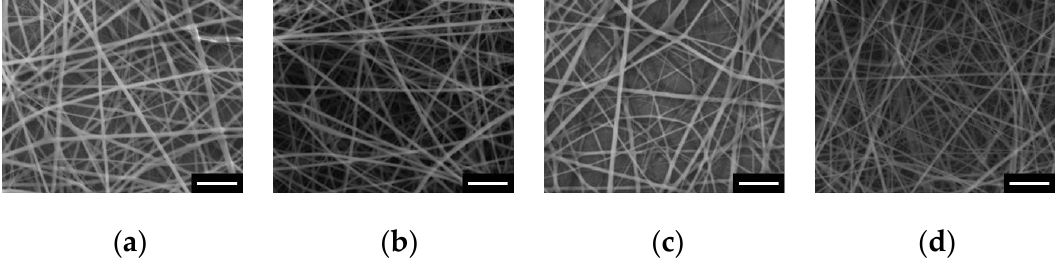
Figure 5. SEM images of PAA nanofibers in a dry state. The nanofibers were prepared by adding ethylene glycol at concentrations of ( a ) 0 wt%; ( b ) 0.16 wt%; ( c ) 1.6 wt%; ( d ) 16 wt% (scale bar: 10 μm).